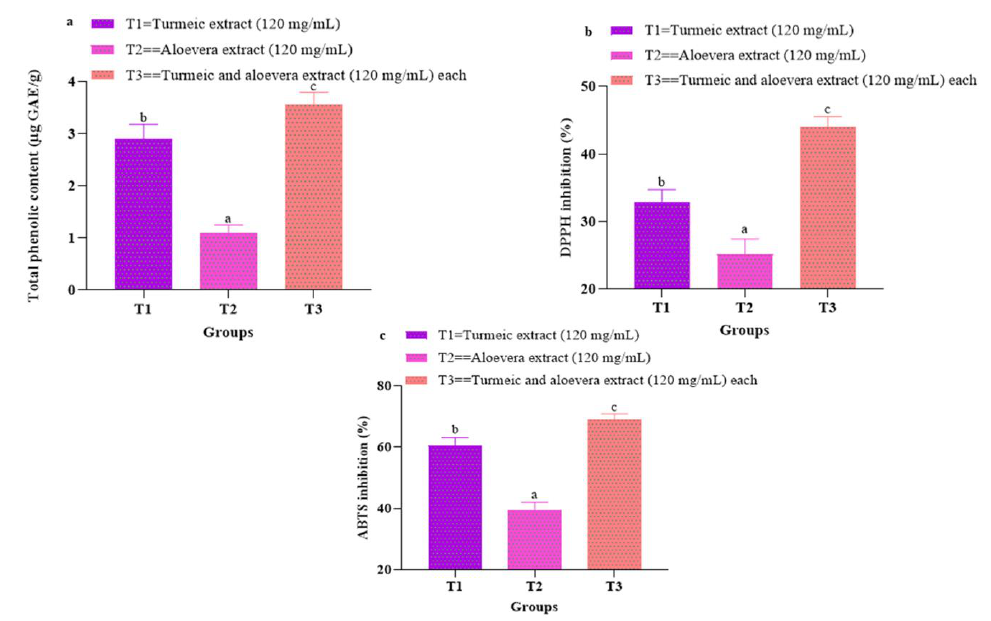
Figure 1. ( a – c ): Total phenolic content, DPPH and ABTS (%) inhibition of turmeric, aloe vera and combination of both extracts. Means bearing different superscripts with small letters a, b, c, d along a row differ significantly at ( p < 0.05). T1: turmeric extract (120 mg/mL); T2: aloe vera extract (120 mg/mL); T3: turmeric (120 mg/mL) and aloe vera (120 mg/mL) extracts.